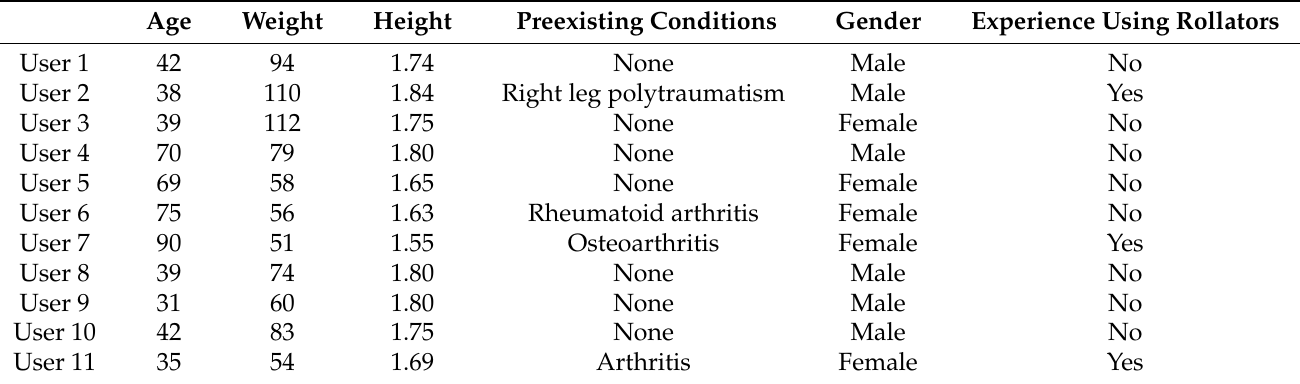
Table 1. Users in